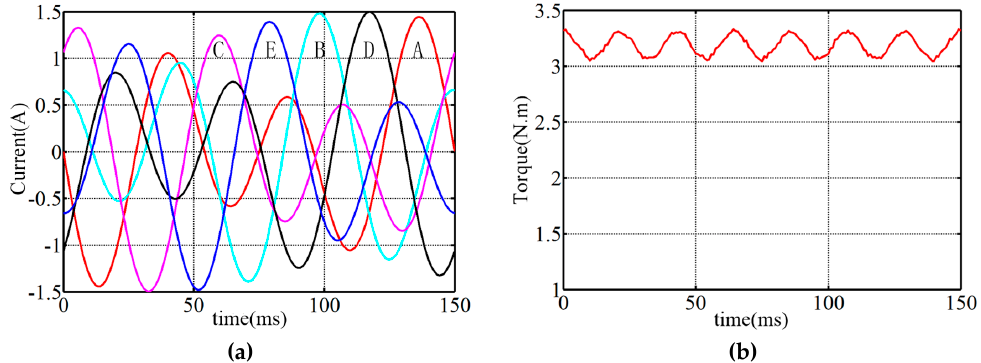
Figure 15. The current and torque simulation of series − connected SIN − FPMSM without i cmp : ( a ) five − phase current; ( b ) torque.